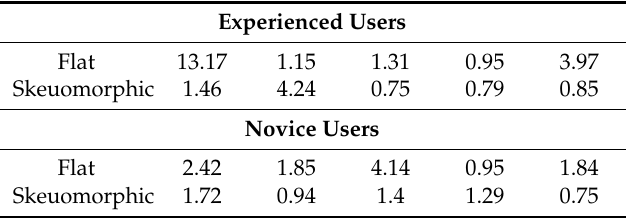
Table 1. Time to first fixation (in seconds).